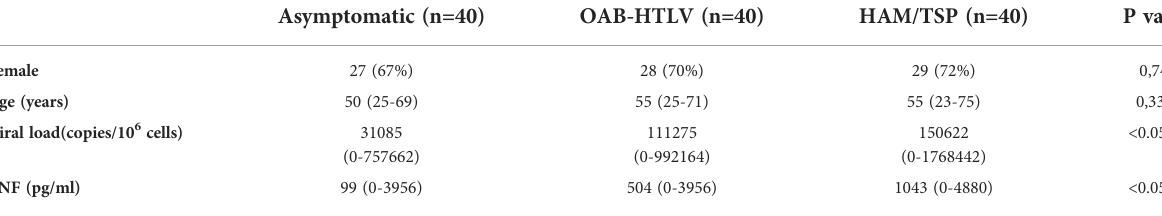
TABLE 1 Clinical and demographical characteristics of studied